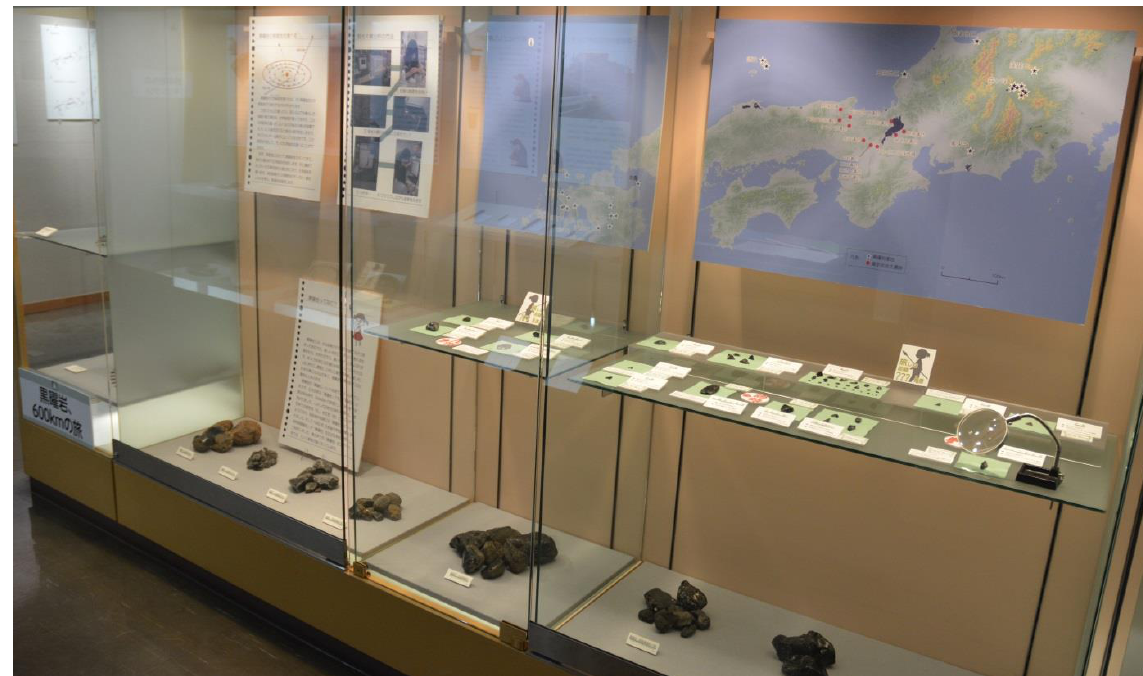
Figure 3. Obsidian exhibition section “Obsidian, 600 km